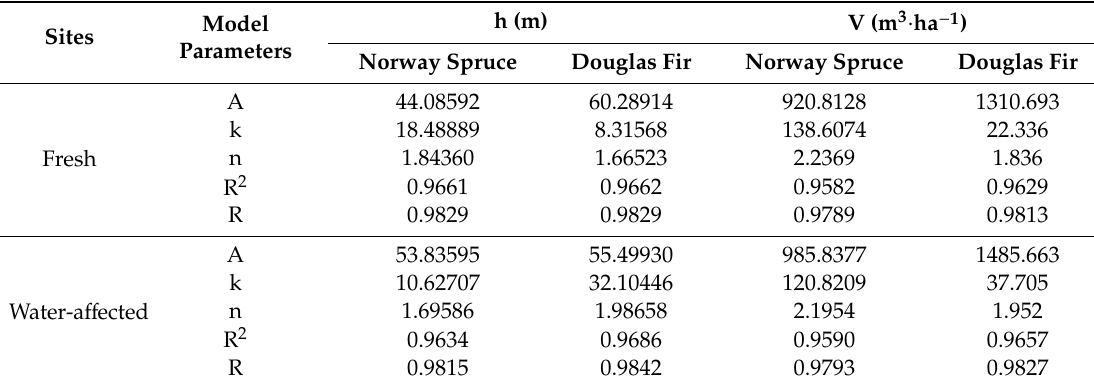
Table 2. Parameters of Korf’s growth model for height (h) and volume stock.